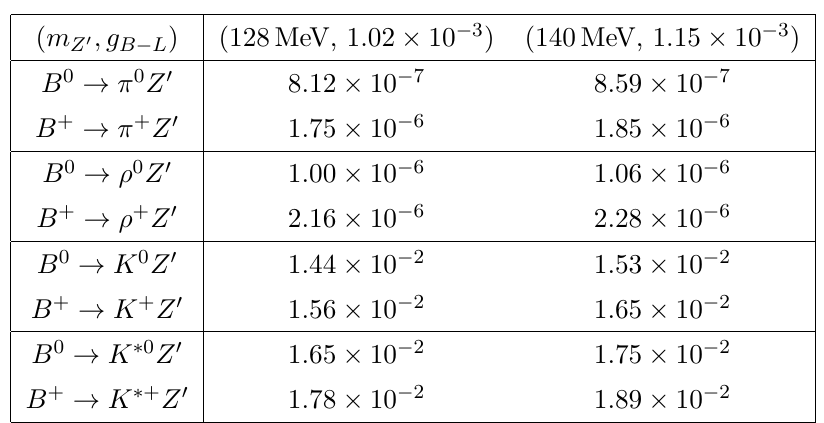
Table 1 . Numerical values for branching ratios of B meson decays. For these values, we use the benchmark values for ( W u ) 1 i in figure 3, and g B − L which realizes BR ( K L → π 0 Z 0 ) = 2 . 1 × 10 − 9 (the central value of the KOTO result) is used as the reference